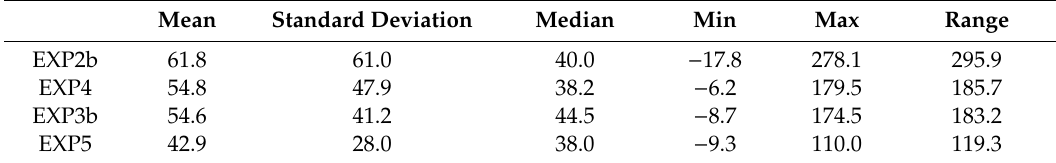
Table 18. LHF (W m − 2 ) simulated by UTOPIA and NOAH, initialized with GLDAS, at the CF station. Mean Standard Deviation Median Min Max Range EXP2b 61.8